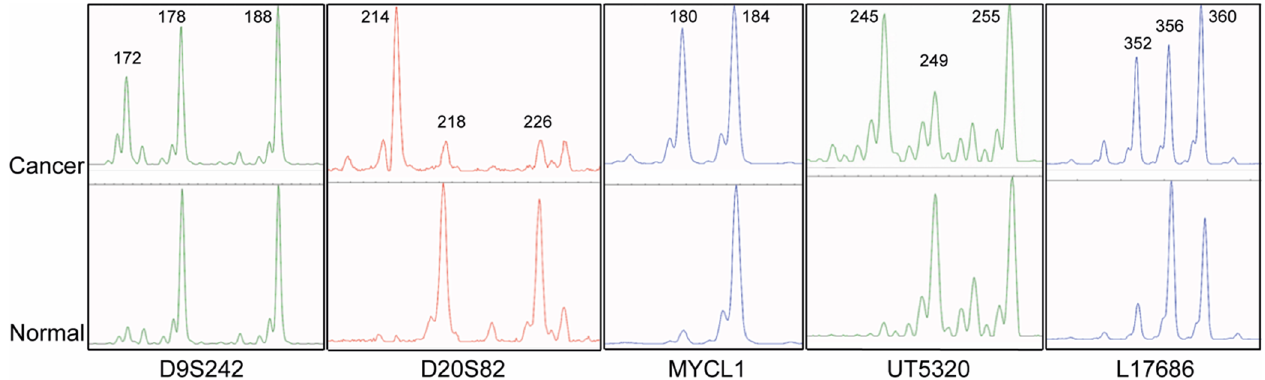
Figure 1. Representative images of EMAST detection using the tetranucleotide repeat markers D9S242, D20S82, MYCL1, UT5320, and L17686 in colorectal cancer. New peaks or change of peak heights in cancer specimens indicate alteration of the repeat length compared to matching normal tissue.